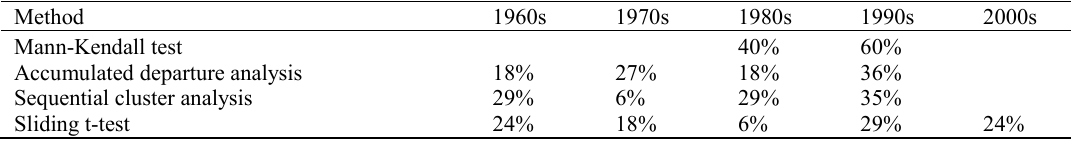
Table 5 Variation changes in runoff (%) over five decades detected using four analytical methods Method